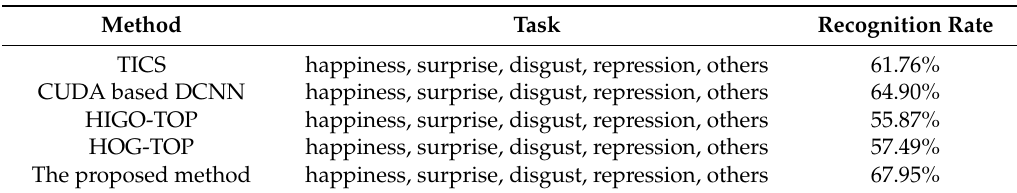
Table 10. Micro-expression recognition rates (%) in CASME II database.